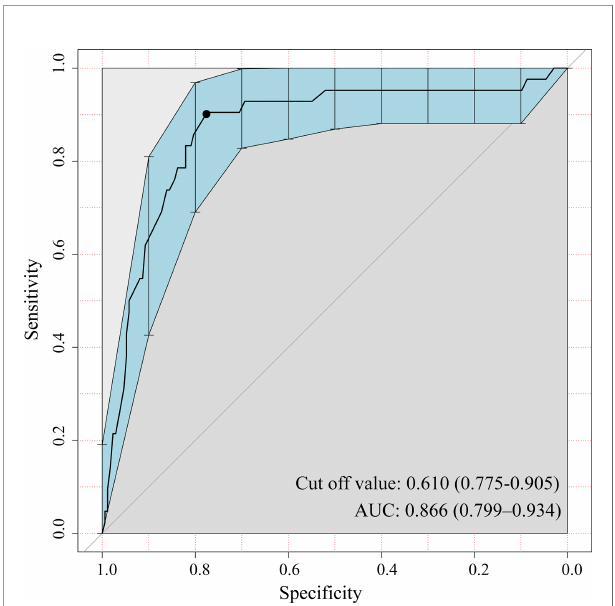
FIGURE 2 | A representative receiver operating characteristic (ROC) curve displayed the classi fi cation performance of consolidation tumor ratio (CTR). The cutoff value is 0.61, which means PSNs are more prone to have positive lymph nodes when CTR >0.61. The area under curve (AUC) is 0.866; 95% con fi dence interval (CI) is shown in blue shade (0.799,